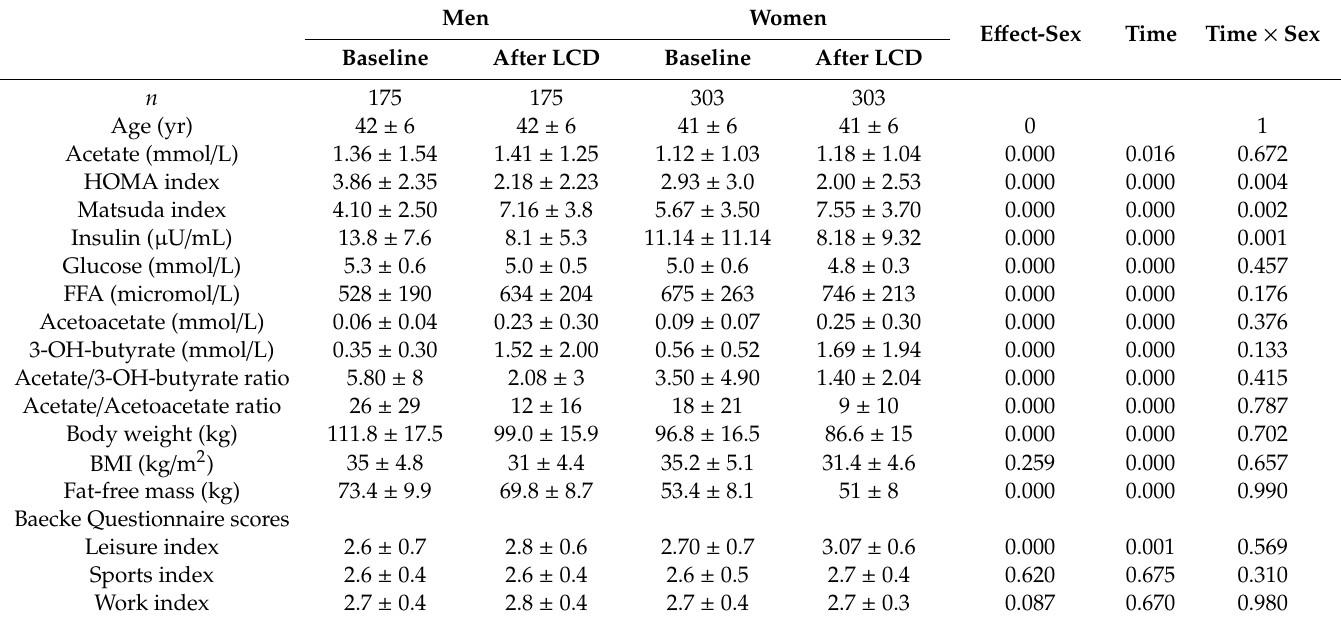
Table 1. Characteristics of participants before and after low calorie diet (LCD)